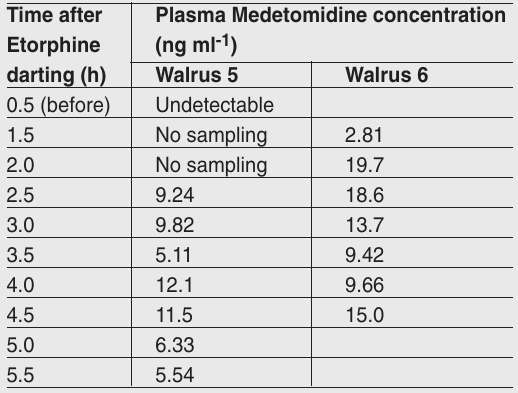
Table 2 . Medetomidine concentrations in blood plasma of two adult male walrus in relation to time during immobilisation involving the initial use of etorphine/